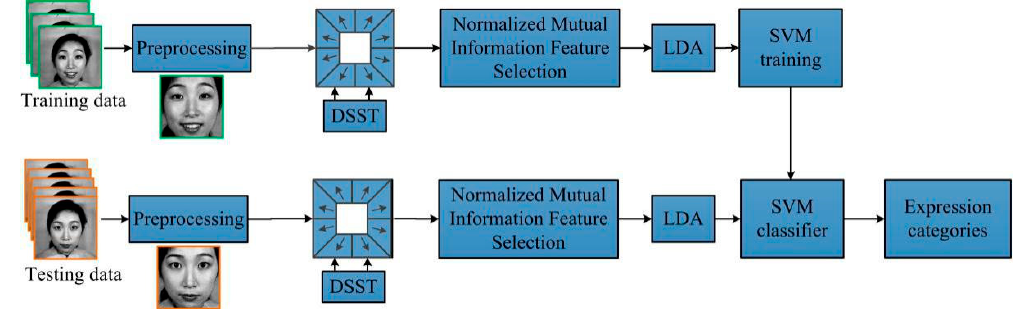
Figure 1. The framework of the proposed method.